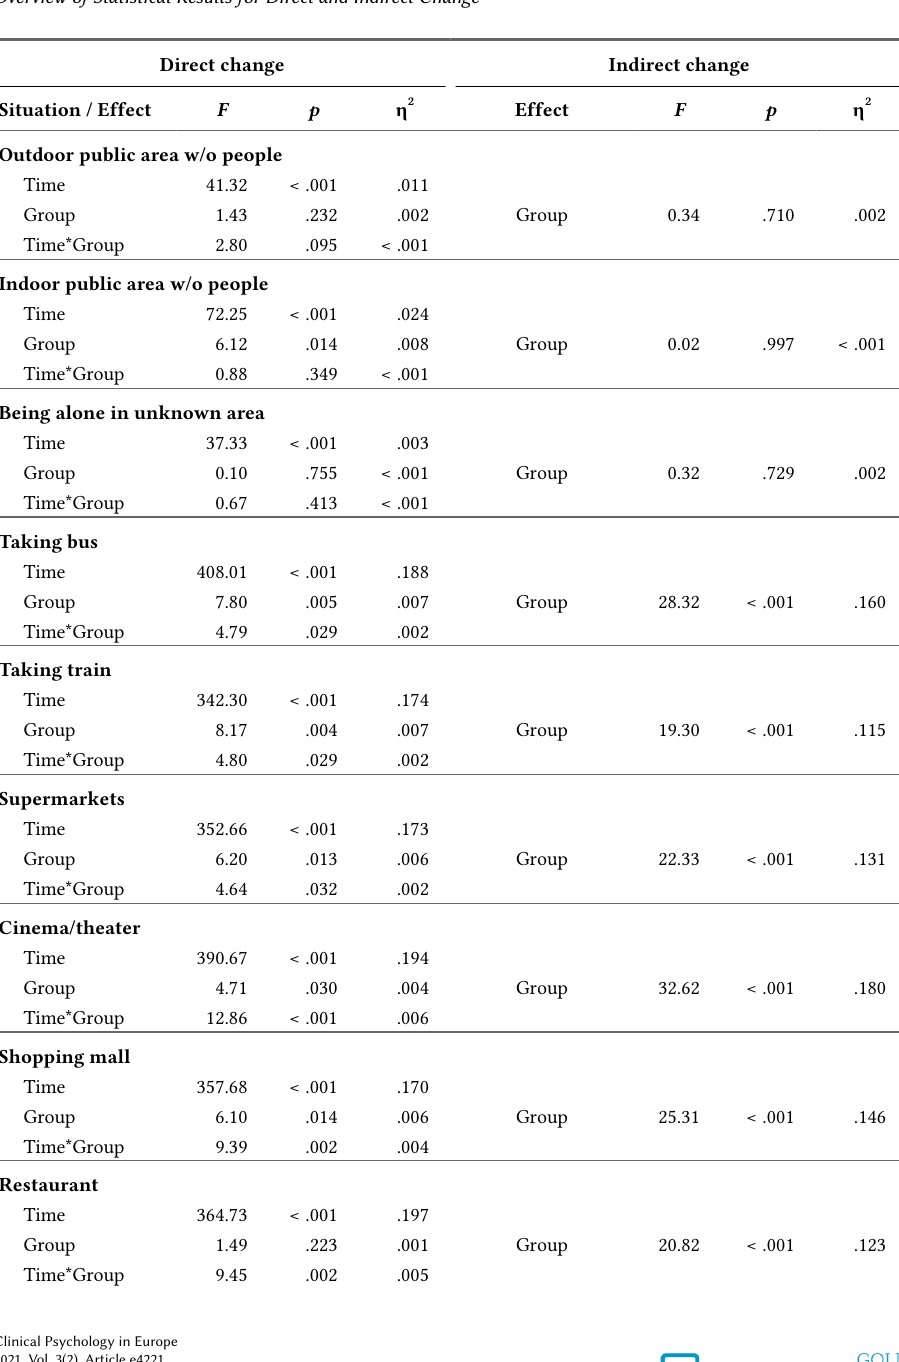
Overview of Statistical Results for Direct and Indirect Change Direct change Indirect change Situation / Effect η 2